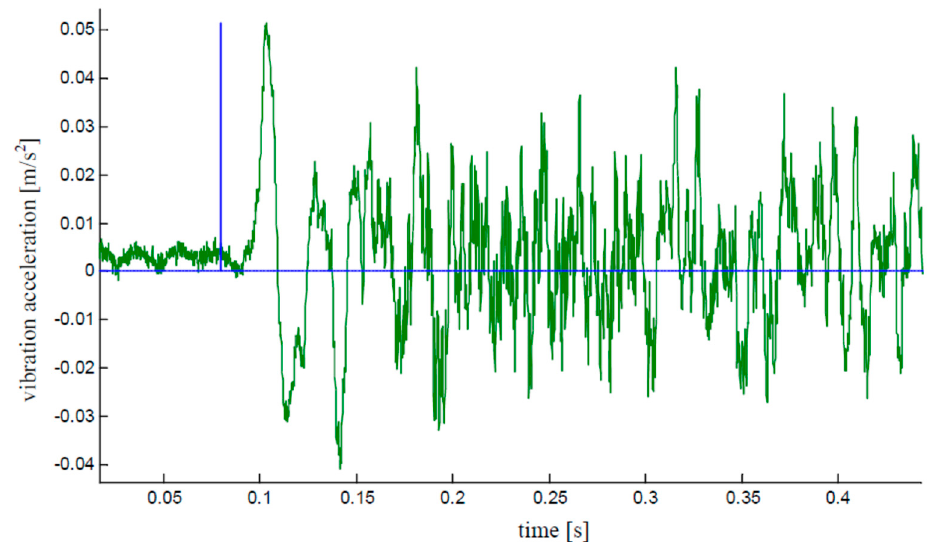
Figure 9. Example of the generated pseudo-impulse and response time history.